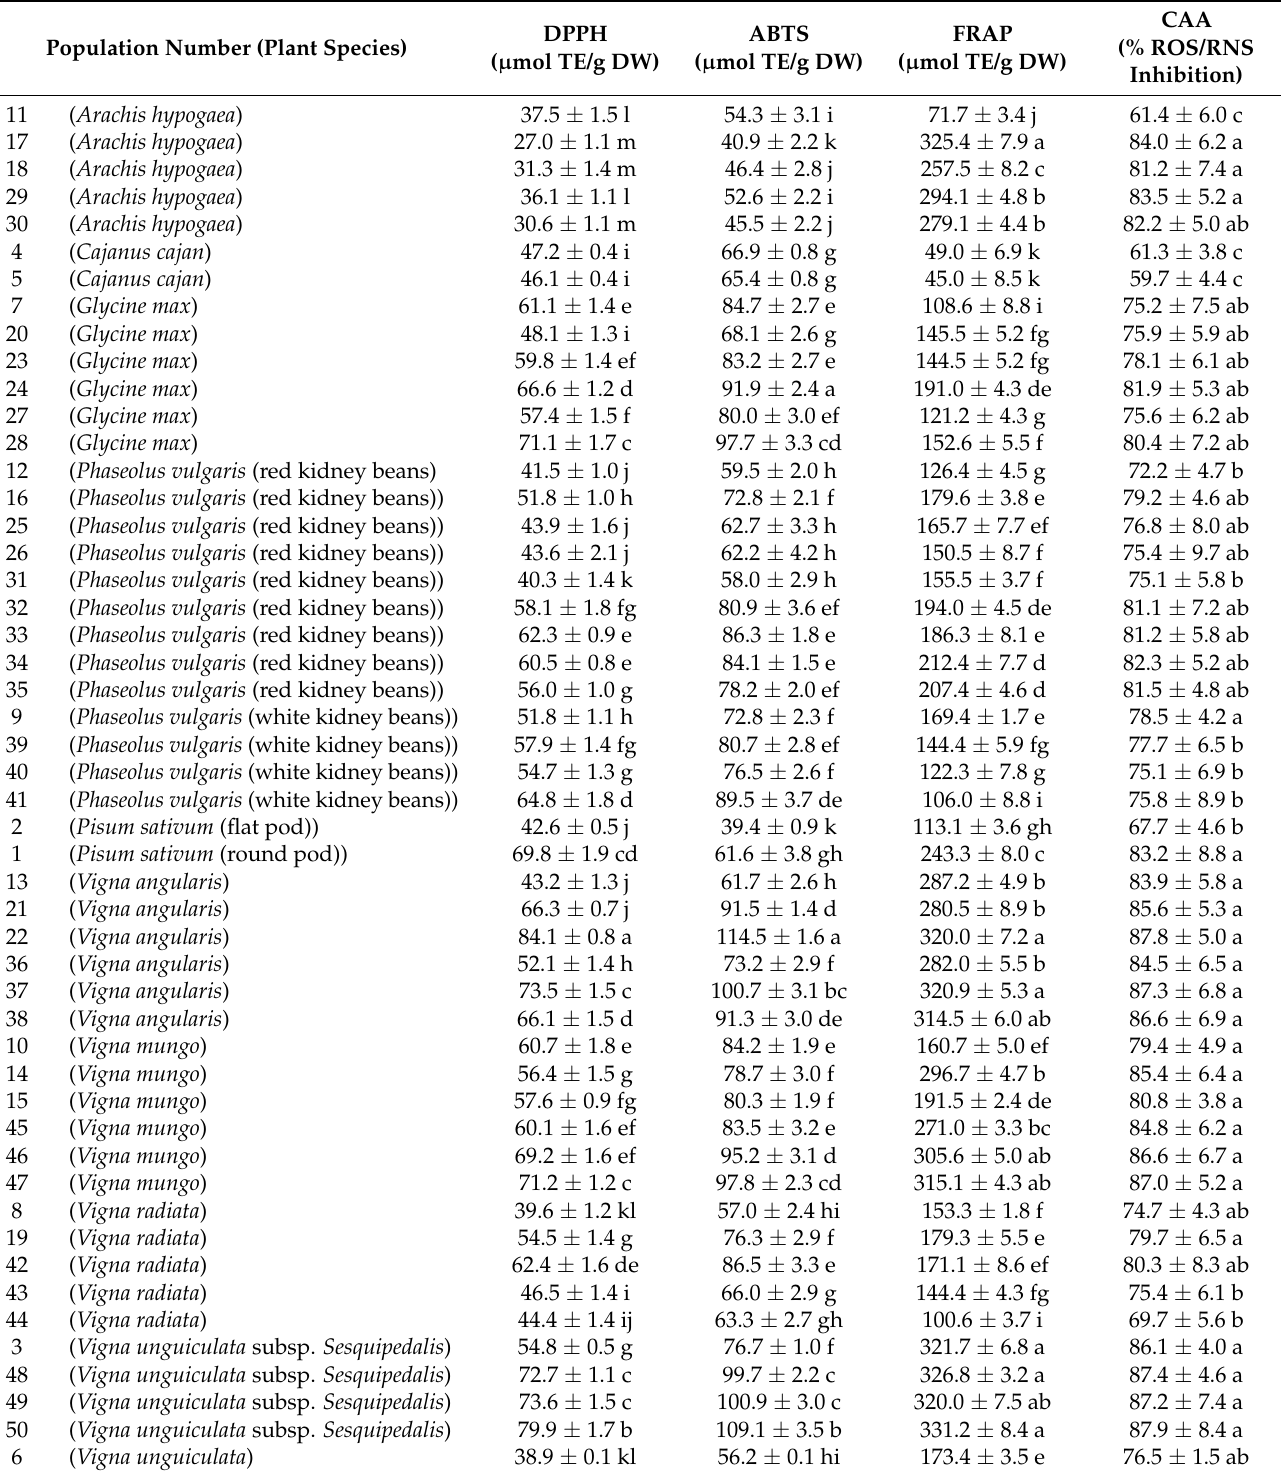
Table 3. In vitro cell-free and cellular antioxidant activity of ethanolic extracts of 50 Fabaceae populations from various floristic regions from